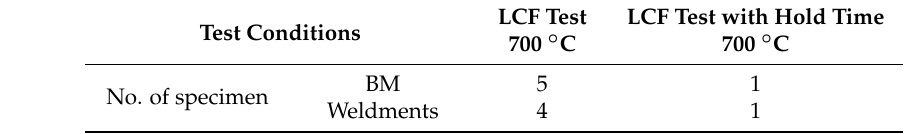
Table 2. Test matrix of tensile and low ‐ cycle fatigue (LCF) tests performed in this study. BM—base metal.